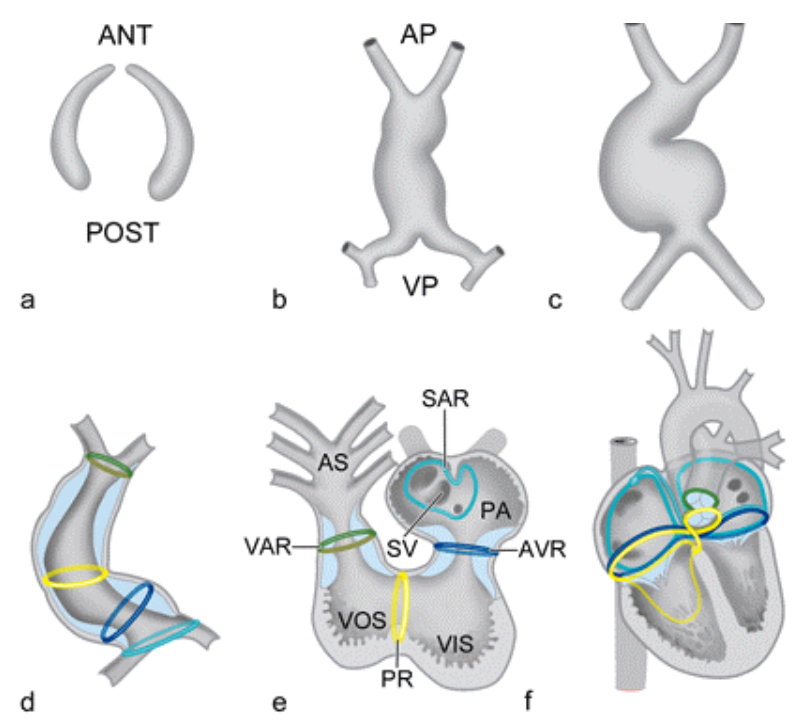
FIGURE 2. Schematic representation of the bilateral formation of the cardiogenic plates, which are derived from the splanchnic mesoderm (a). The bilateral plates fuse and form an initially straight heart tube (b) that starts looping to the right (c,d). After looping, so-called transitional zones or rings can be recognized in the heart that are positioned in between the putative cardiac chambers, i.e., the sinoatrial transition (SAR), the atrioventricular transition (AVR), the primary ring (PR), and the ventriculoarterial transition (VAR) (e). Position of these rings during further cardiac development (f). Ant: anterior, AP: arterial pole, AS: aortic sac, PA: primitive atrium, post: posterior, SV: sinus venosus, VIS: ventricular inlet segment, VOS: ventricular outlet segment, VP: venous pole. Panel a–c adapted from Gittenberger-de Groot et